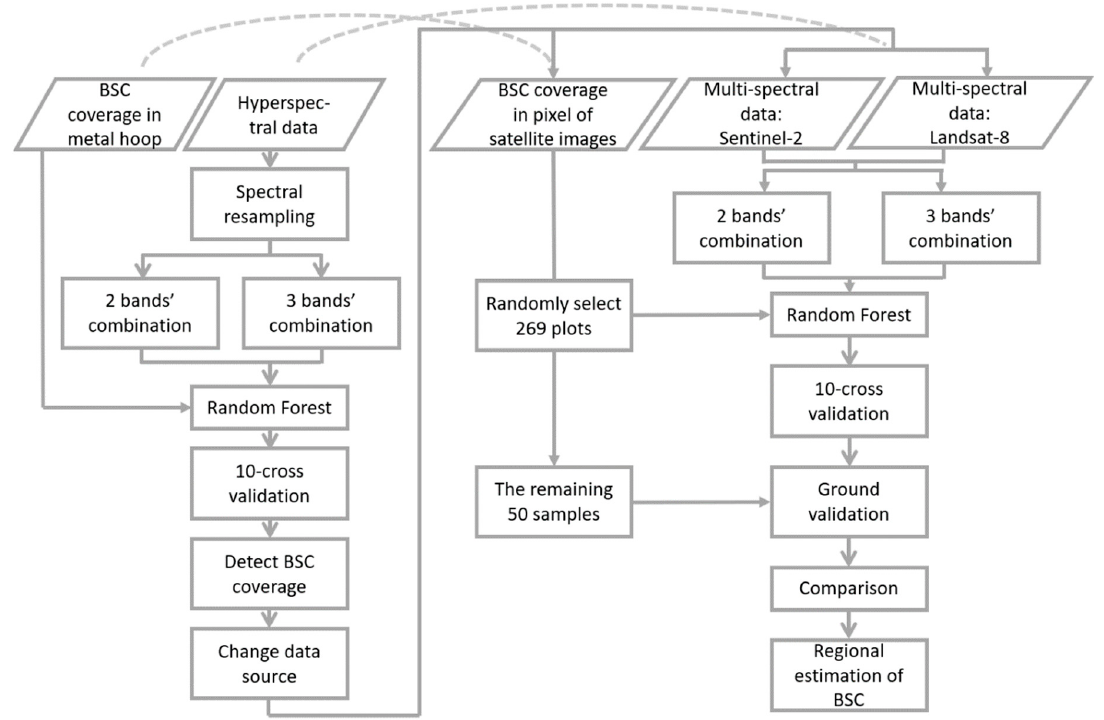
Figure 4. Flow chart of the study process.